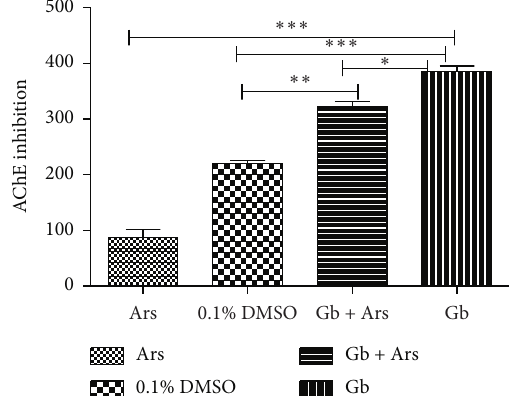
Figure 6: Acetylcholinesterase inhibition assay of adult Javanese medaka treated with arsenic, crude extract, and arsenic and crude extract. The percentage of acetylcholinesterase inhibition is shown versus concentration of the tested sample (arsenic, crude extract, and crude extract and arsenic). ∗ P < 0 . 001, P < 0 . 01, and P < 0 . 05 represents significant different values of the control group and group exposed to arsenic only, crude extract and arsenic, and crude extract only. The values represent mean ± SD from three ( n � 3) independent experiments.